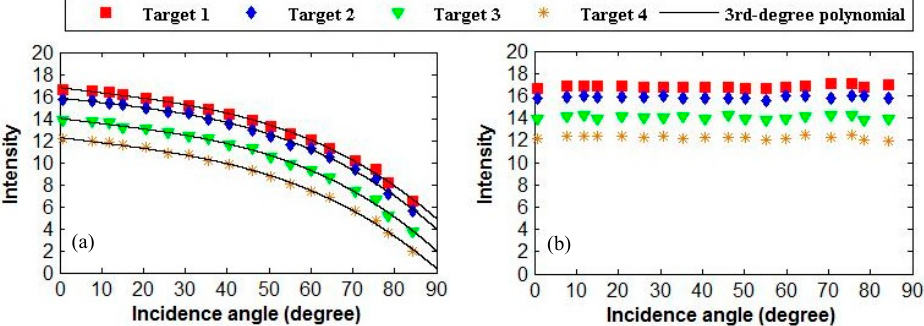
Figure 4. ( a ) Experimental results between the incidence angle and original intensity of the four reference targets. The black lines are the 3rd-degree fitting polynomials. ( b ) Incidence angle with respect to the corrected intensity data of the four reference targets by the first equation of Equation (5) ( θ s = 0 ◦ ).